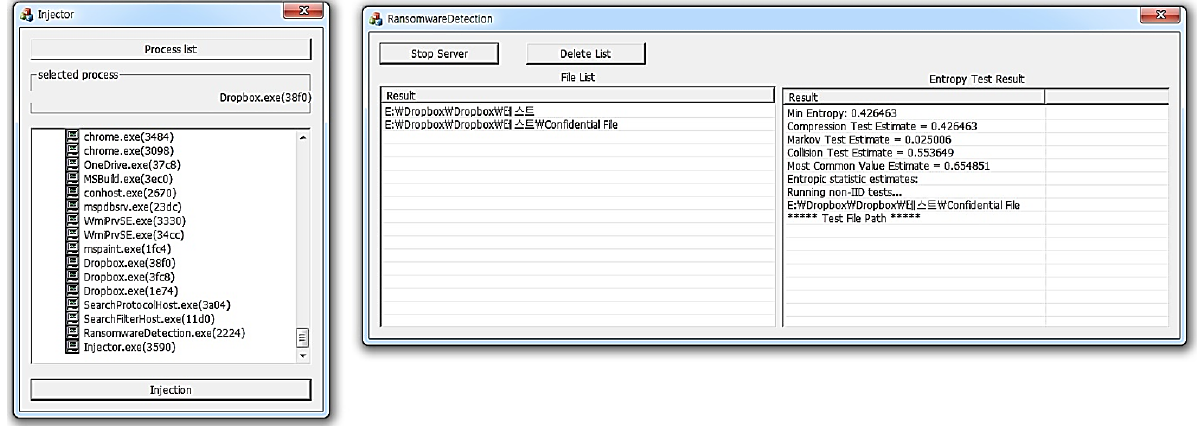
Figure 4. Results of the entropy estimation for a single file synchronized with